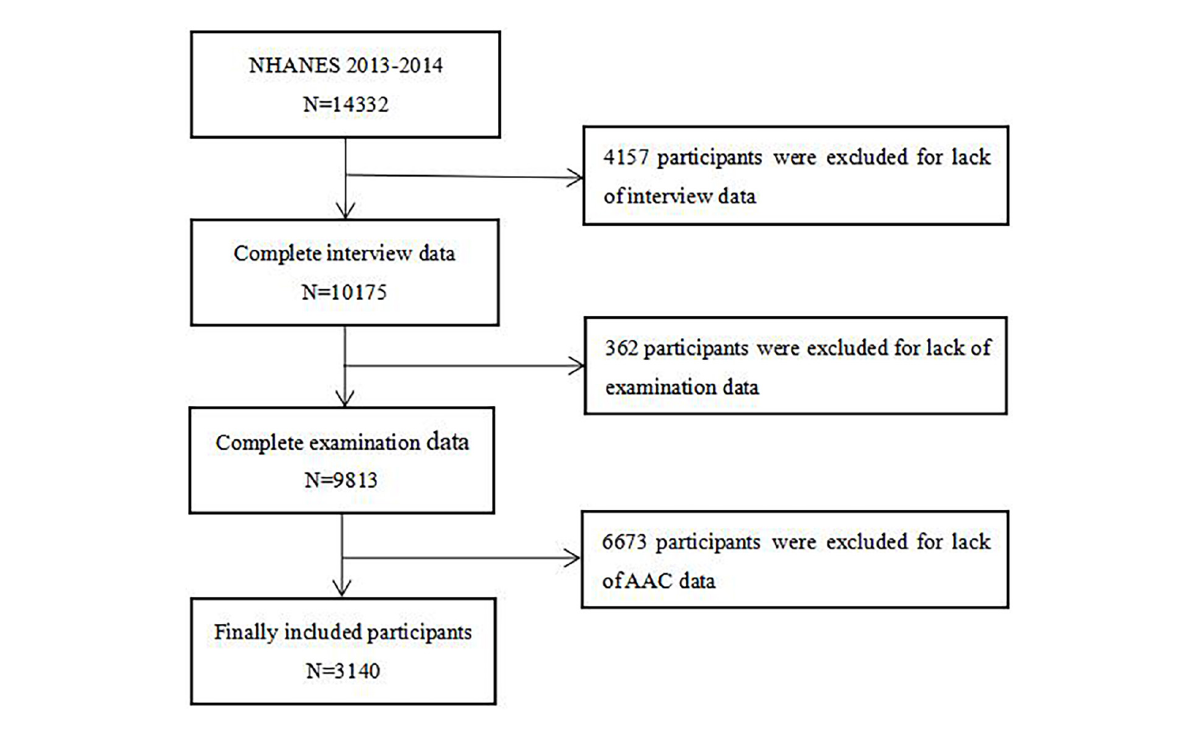
FIGURE1 Flow chart of the study population enrollment. NHANES 2013–2014, 2013–2014 National Health and Nutrition Examination Survey; AAC, abdominal aortic calcification.